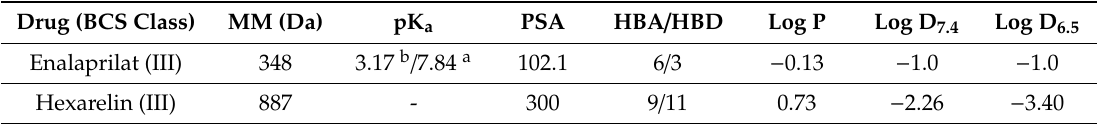
Table 1. Some physicochemical properties of the biopharmaceutics classification system (BCS) class of enalaprilat and